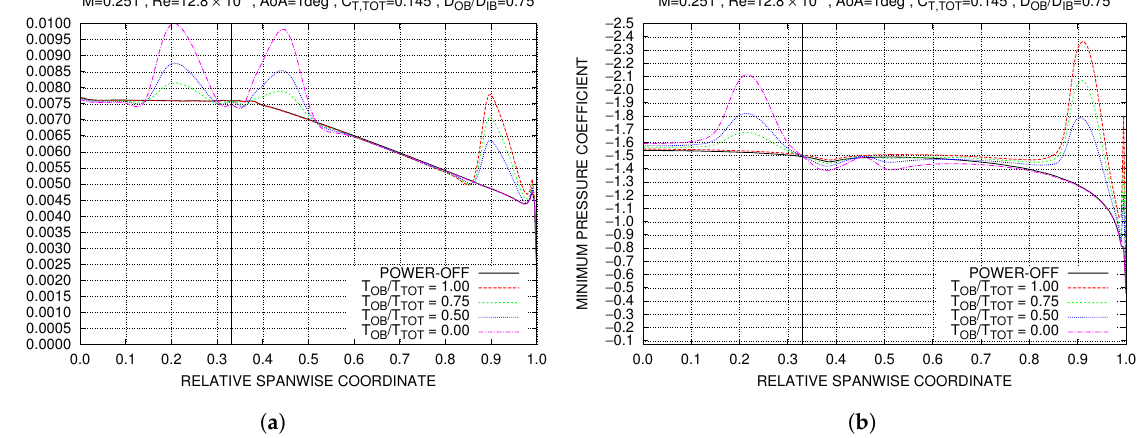
Figure 17. Wing spanwise loading with IB and OB propellers in climb conditions at constant total thrust: ( a ) friction drag coefficient derivative; ( b ) minimum pressure coefficient.